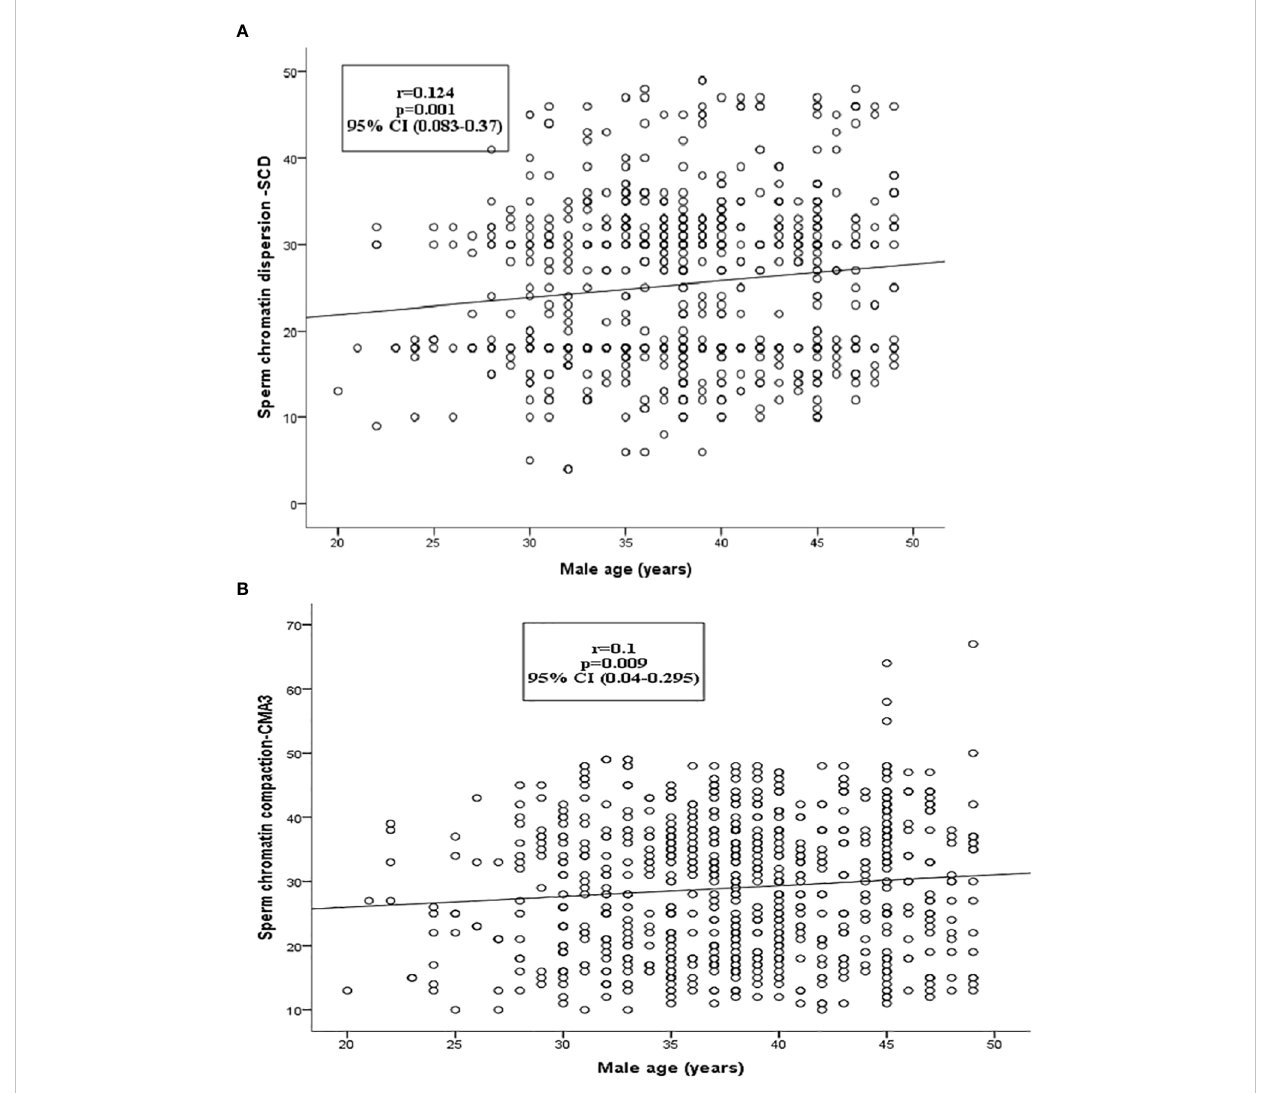
FIGURE 2 The relationship between sperm chromatin dispersion and sperm chromatin compaction (CMA3+) to male age. (A) The left charts show scatterplot correlation lines depicting the association between sperm chromatin dispersion (SCD) and male age. (B) Sperm chromatin compaction/protamine (CMA3+) and male